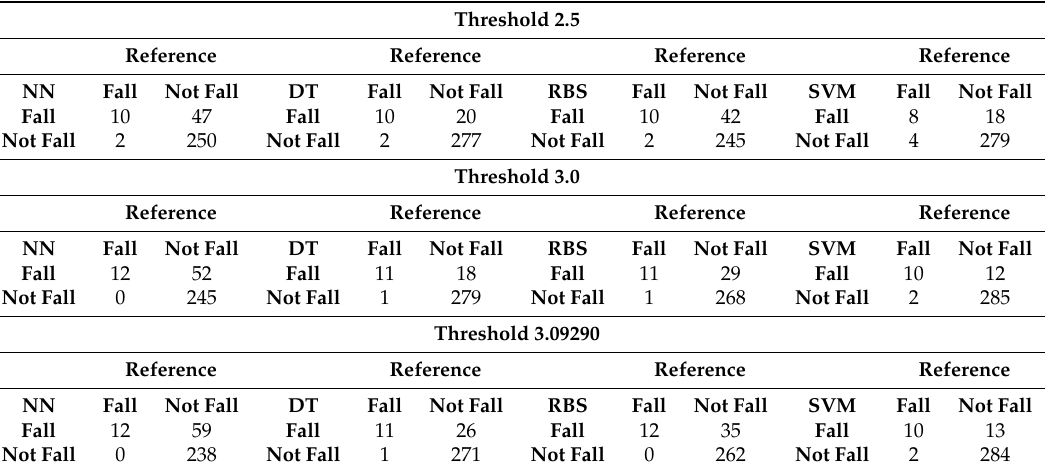
Table 11. Confusion matrices for the three analyzed thresholds and for each model type: feed forward NN, Decision Trees learned with C5.0 (DT), Rule-Based Systems learned with C5.0 (RBS) and Support Vector Machines